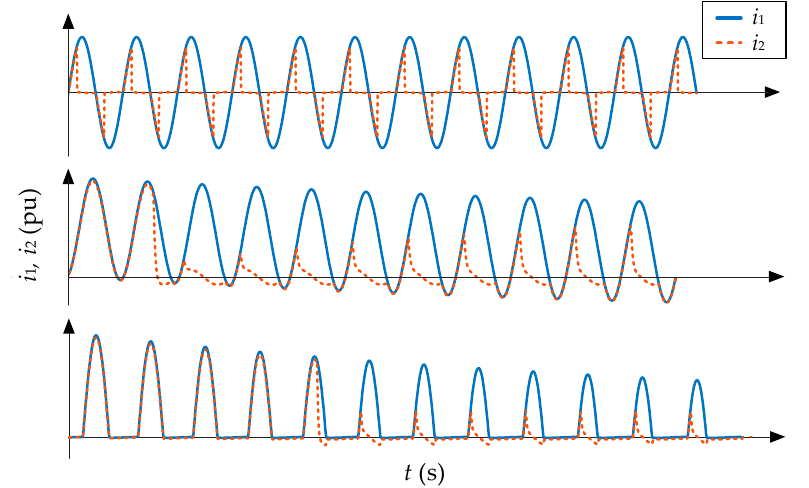
Figure 2. Typical waveforms of different saturated secondary currents (dotted lines) against pri- mary currents (solid line): large symmetrical current ( top ), fault current ( center ), and inrush cur- rent ( bottom ).